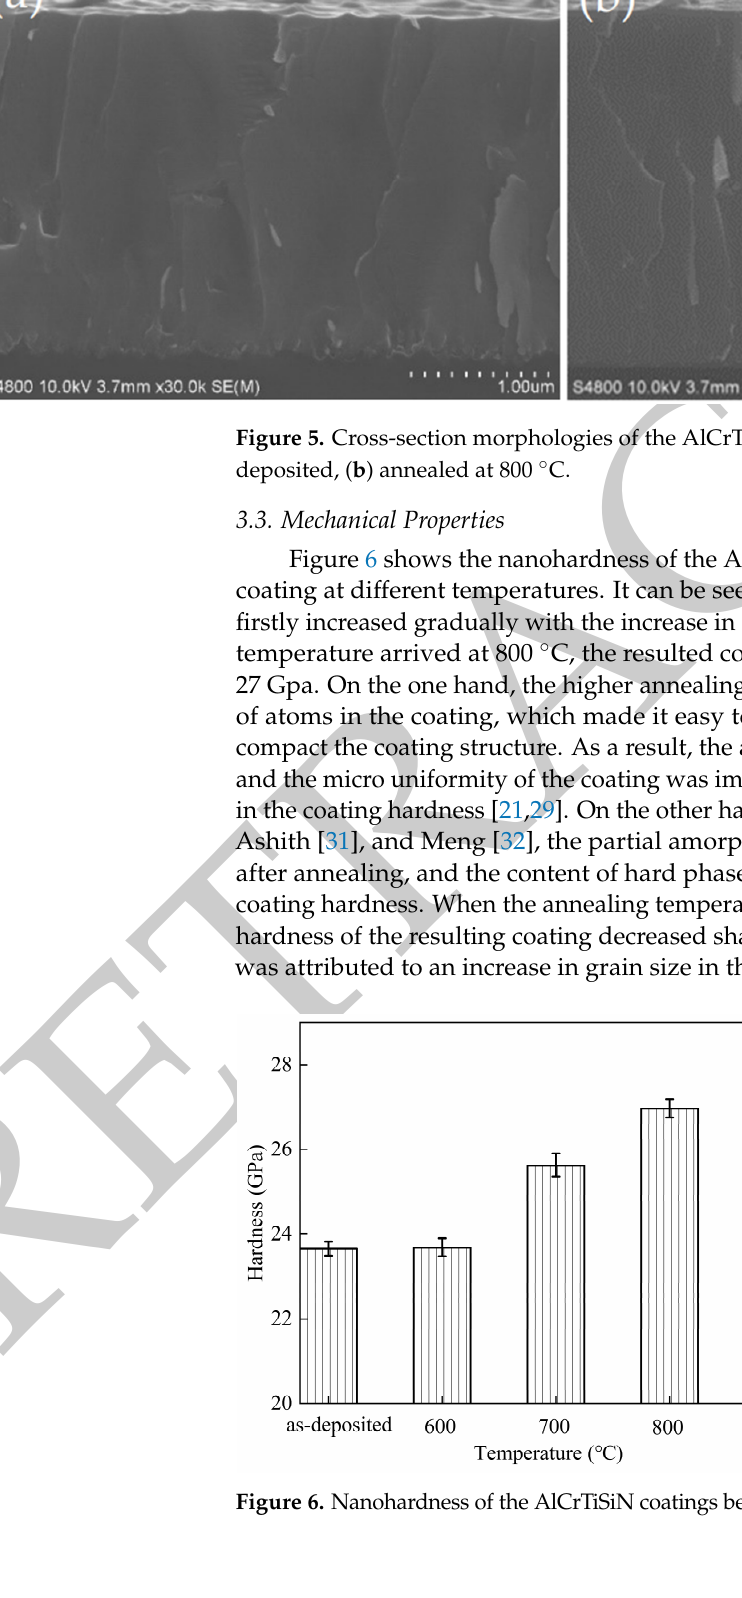
Figure 7. Critical load of the AlCrTiSiN coatings before and after annealing at different tempera- tures.